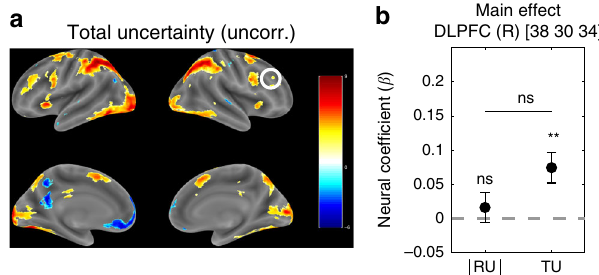
Total uncertainty (uncorr.)